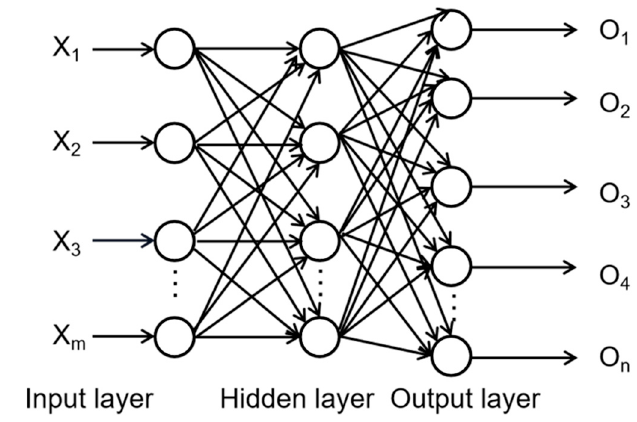
Figure 4. Three-layer Feed-forward Neural Network structure.